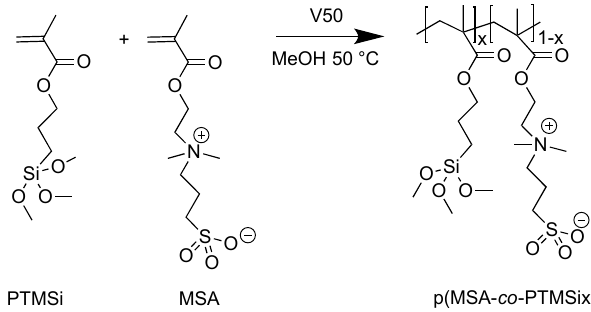
Figure 1. Synthesis of the zwitterionic copolymers based on hydrophilic MSA and PTMSi (x = 1, 5 mol%).